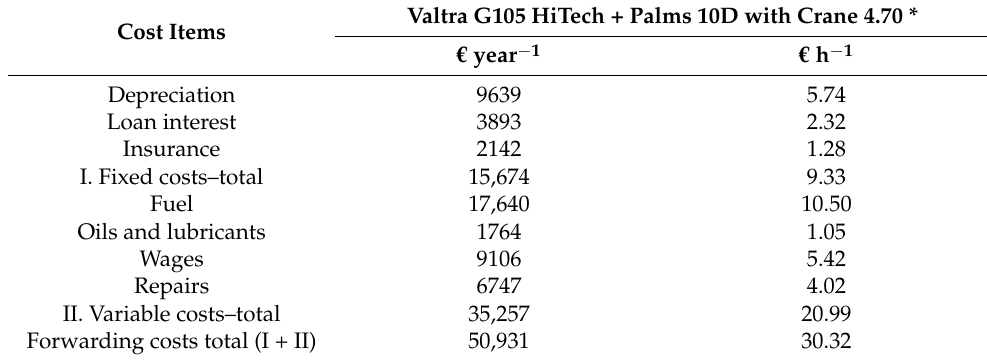
Table 5. Calculation of annual and hourly direct costs of short wood forwarding.